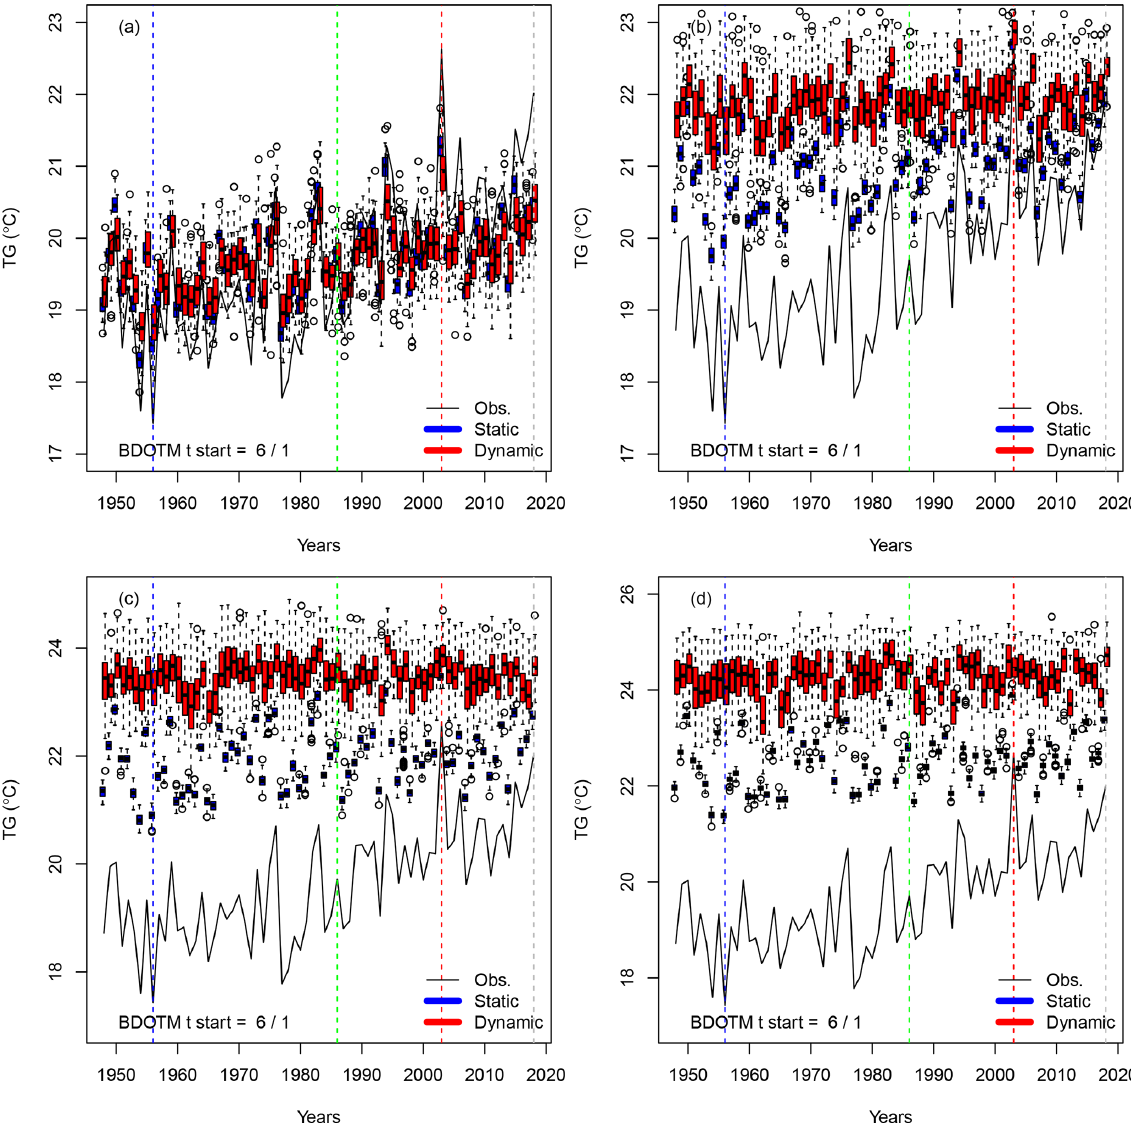
Figure 4. Time variations of probability distributions of simulated average temperatures (TG in degrees Celsius) for four values of the weight on temperatures α TG : (a) α TG = 0; (b) α TG = 0 . 2; (c) α TG = 0 . 5; (d) α TG = 1. The black continuous line represents the observed variations in Berlin–De Bilt–Orly–Toulouse–Madrid (BDOTM) summer averages between 1948 and 2018. The vertical colored lines outline the coldest (blue), median (green), warmest (red) and 2018 summers. The box plots represent the ensemble variability of the simulations for each year. The red box plots are for the dynamic simulations. The blue box plots are for the static simulations. The boxes of box plots indicate the median ( q 50 ), lower ( q 25 ) and upper ( q 75 ) quartiles. The upper whiskers indicate min [ max (T ), 1 . 5 × (q 75 − q 25 ) ] . The lower whisker has a symmetric formulation. The points are the simulated values that are above or below the defined